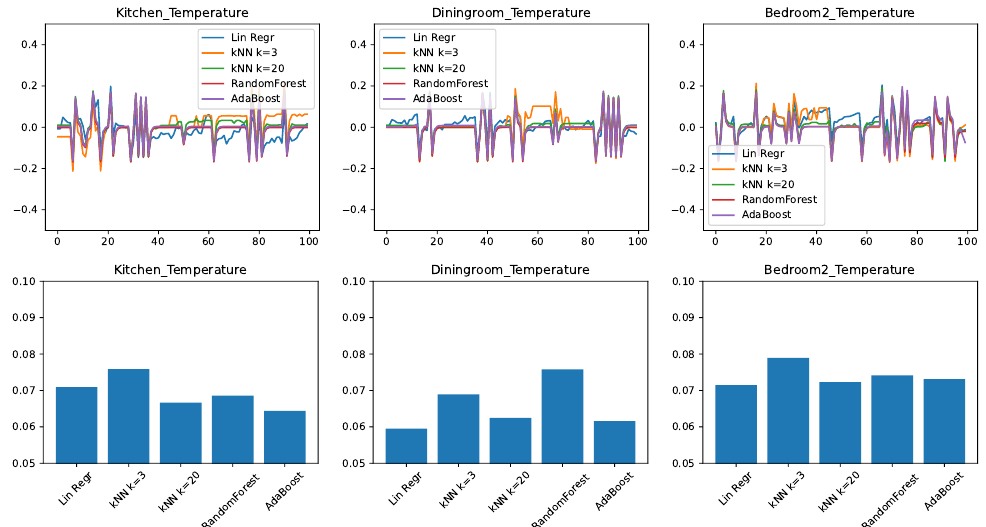
Figure 4. Comparing different regressors for temperature change prediction with a large feature set. ( top ) Prediction error in time. ( bottom ) RMSE over the test set.